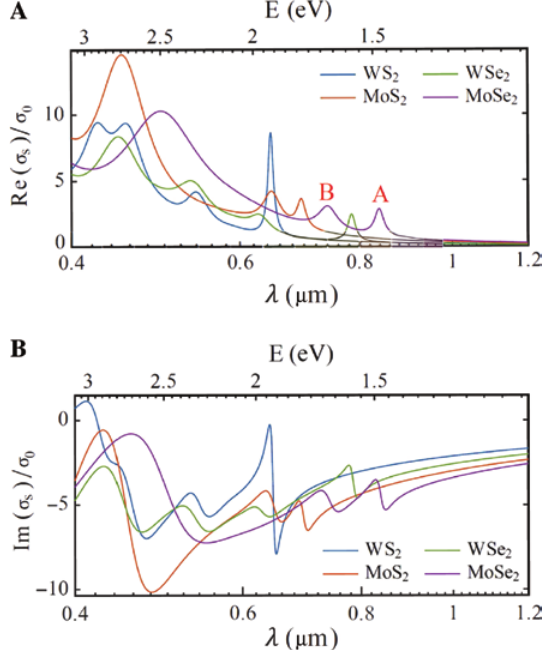
Figure 2: Dispersion of the complex sheet conductance of several TMDCs. Frequency dependence of the real (A) and imaginary (B) parts of the sheet conductance of several TMDC monolayered materials, respectively. Reproduced from Ref.